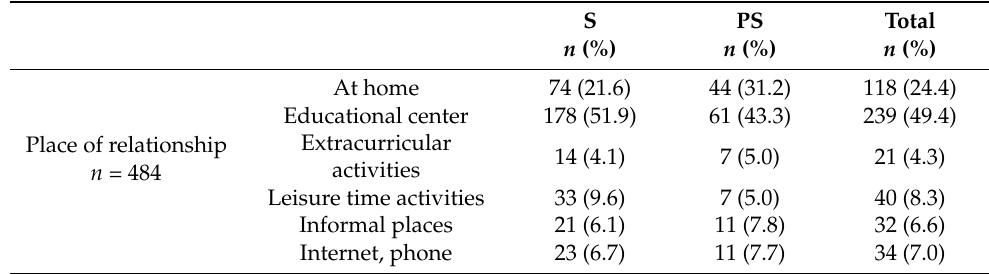
12 of 20 Table 7. Legend of graph. Node Shape: